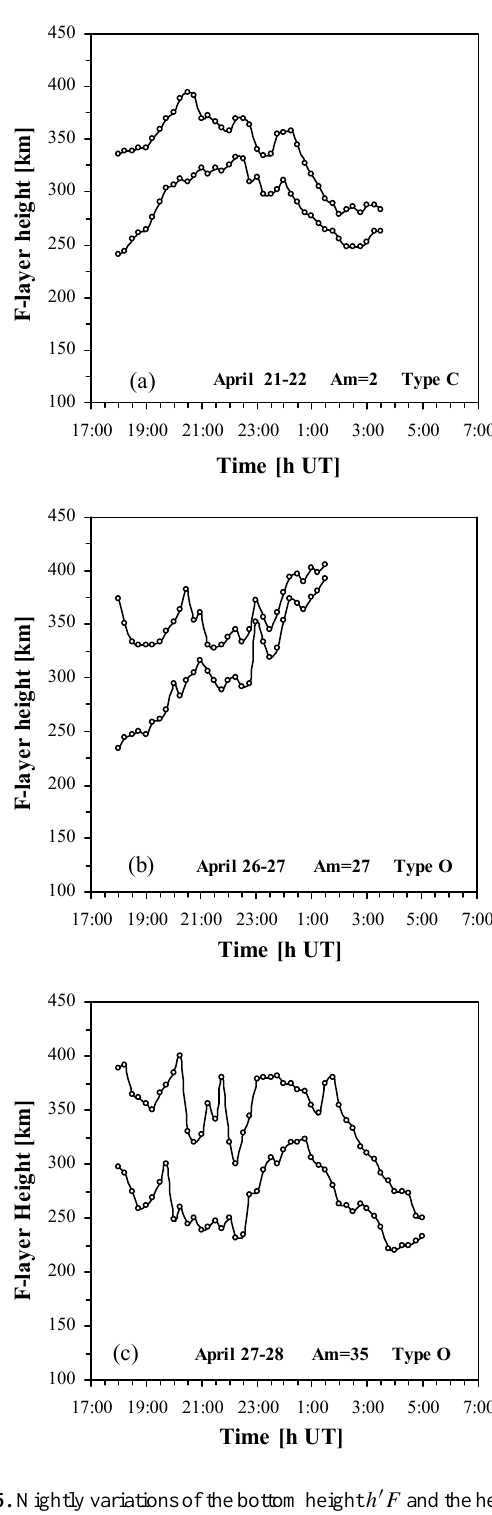
Fig. 5. Nightly variations of the bottom height h 0 F and the height of the maximum electronic density hpF for three nights after 21 April, (a) 21–22 April: C-type contour, (b) 26–27 April: O-type contour, (c) 27–28 April: O-type contour. Note that the O-type contours change from one day to the next and do not show any similarity with the A, B and C-type